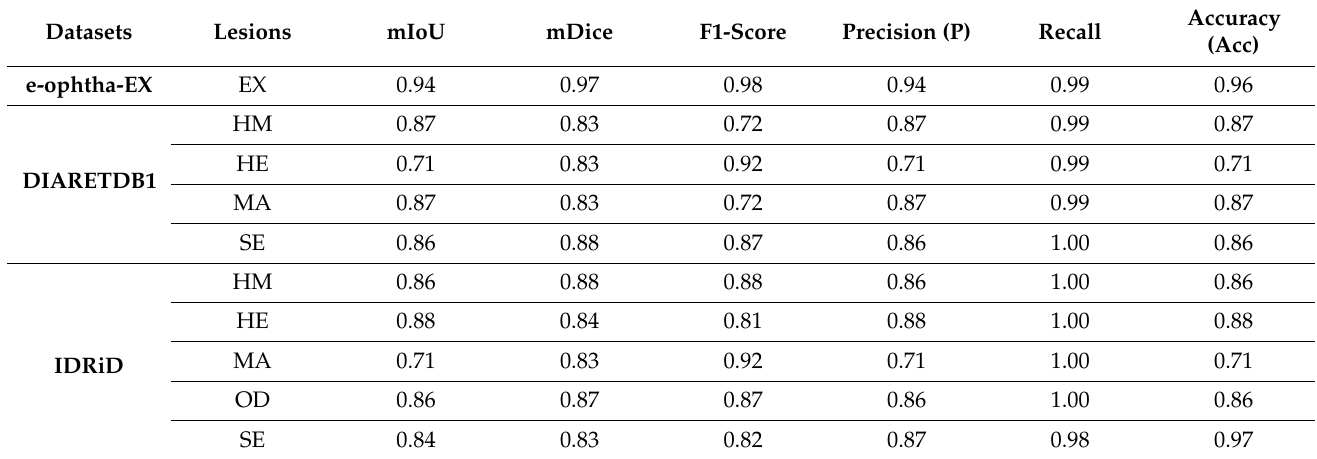
Table 5. Results of segmentation method using benchmark